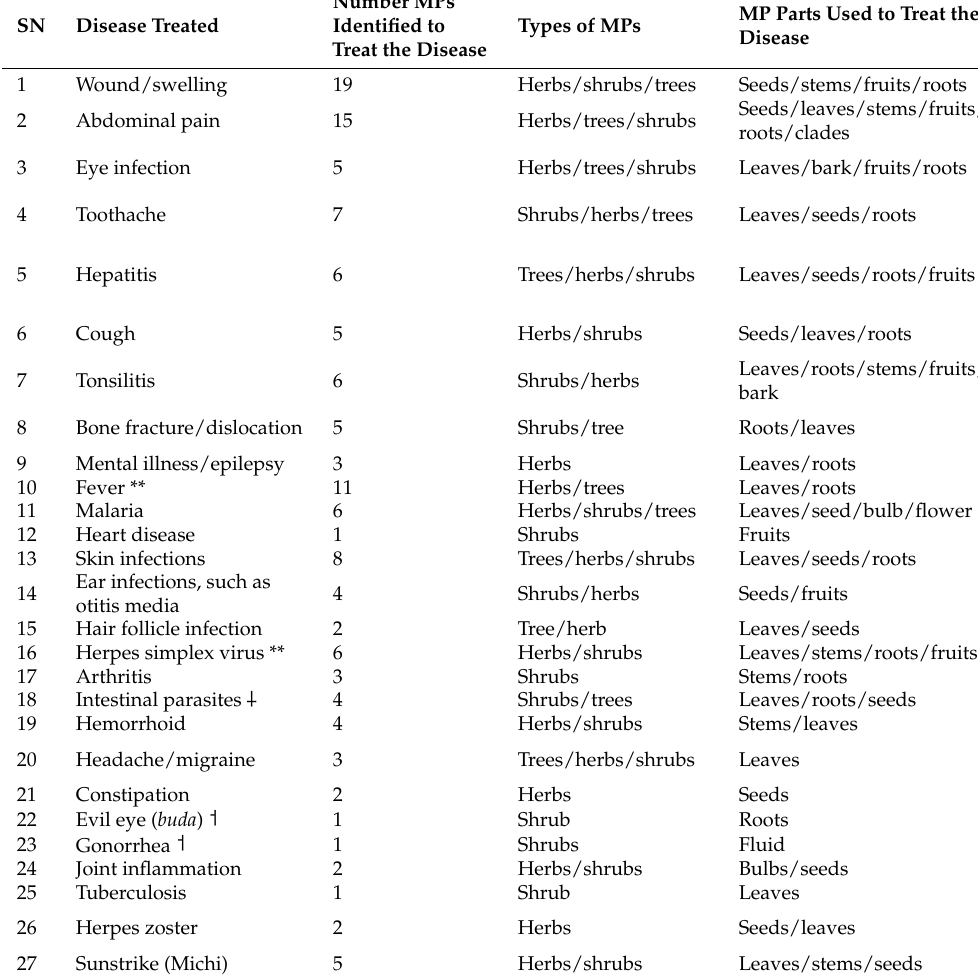
** Parts of two or more plants are combined and used to treat fever . ⸸ Intestinal parasites include tapeworm and hookworm, ⸶ information obtained from key informant; δ snake and other insect repellents. Table 2. Medicinal plants identified and the administration method used to treat animal diseases and manage insect infestations, recorded in the study FDGs.